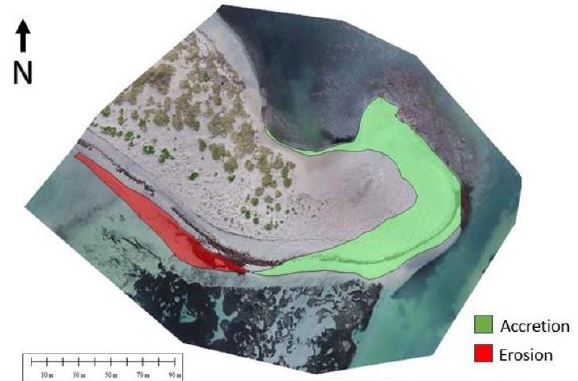
Figure 11: Coastline movement between epochs 1 and 2.